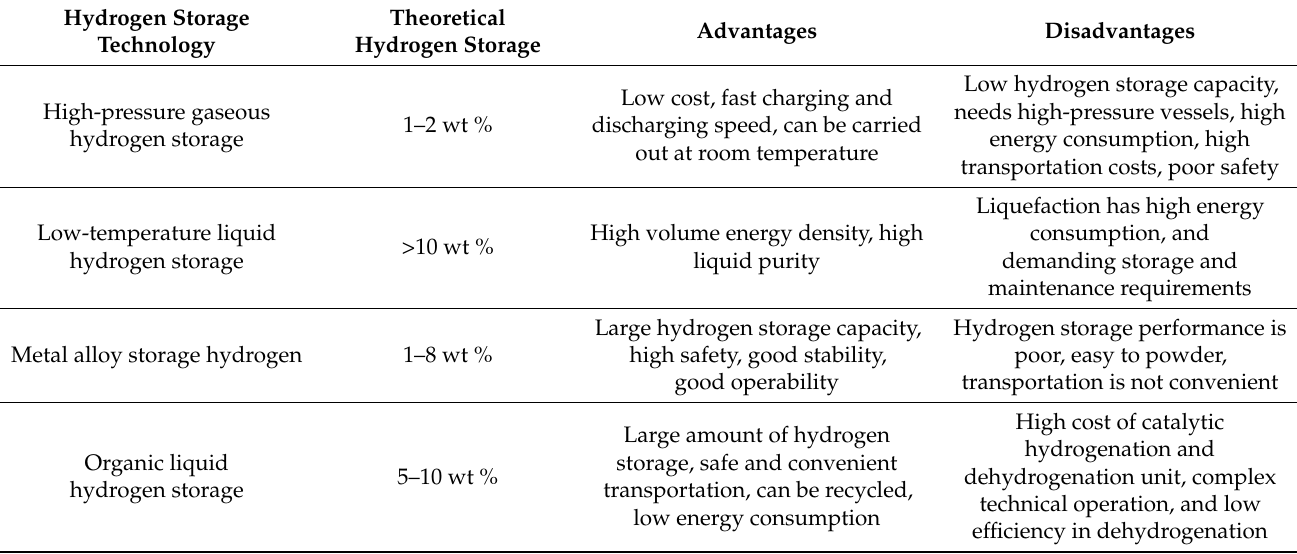
Table 2. Advantages and disadvantages of hydrogen storage technologies [60].